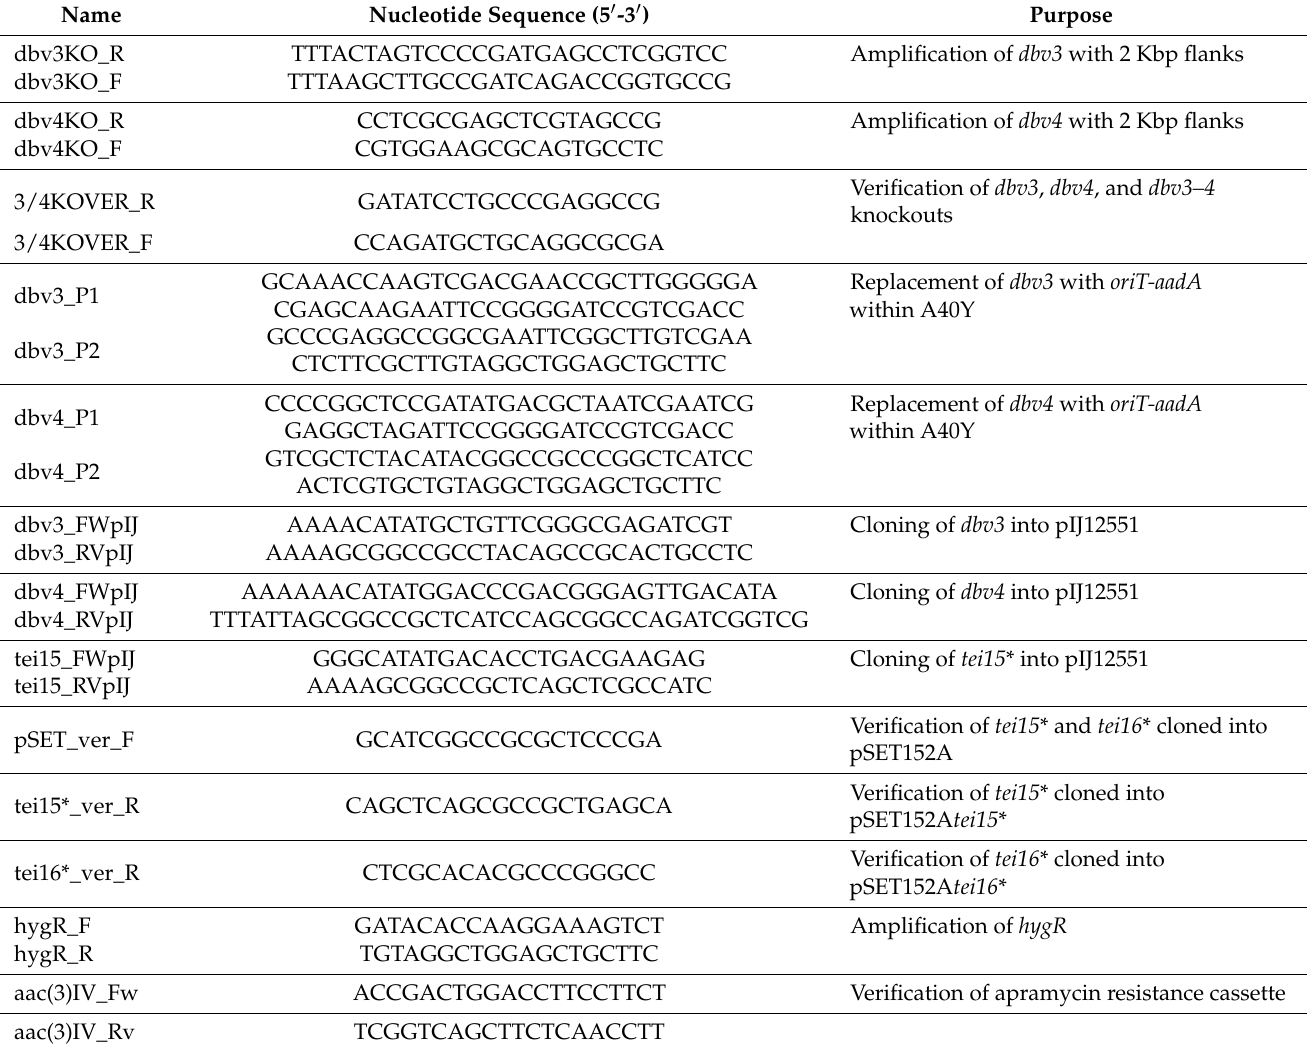
Table 2. Oligonucleotide primers used in this